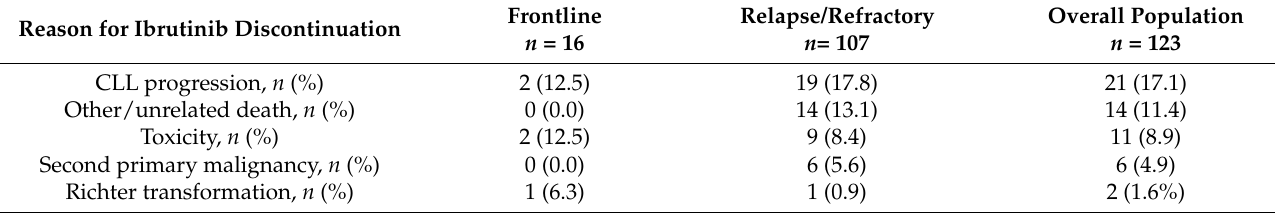
Table 6. Reasons for ibrutinib cessation.